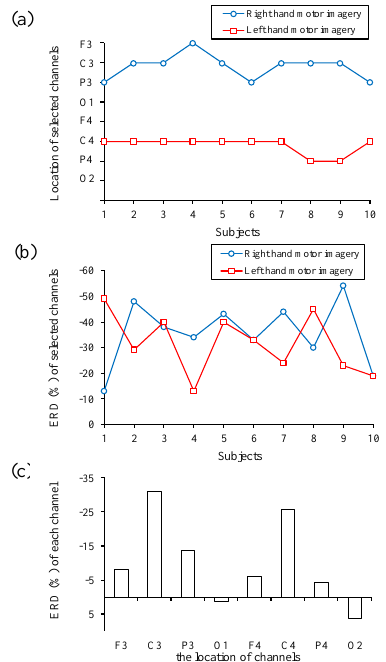
Figure 8. Experimental results for ( a ) locations and ( b ) ERD quantifications of selected EEG channels; and ( c ) averaged ERD quantifications of each EEG channel for the right and the left hand motor imagery.